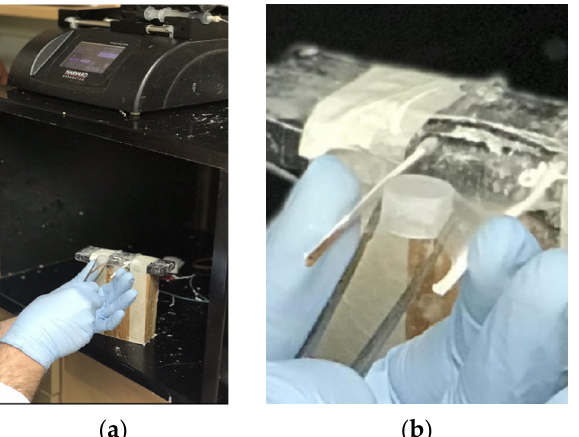
Figure 2. ( a ) Preparation of sample molds with nanofiber mesh in electrospun environment. ( b ) thin PCL film being collected onto a plastic cylinder.